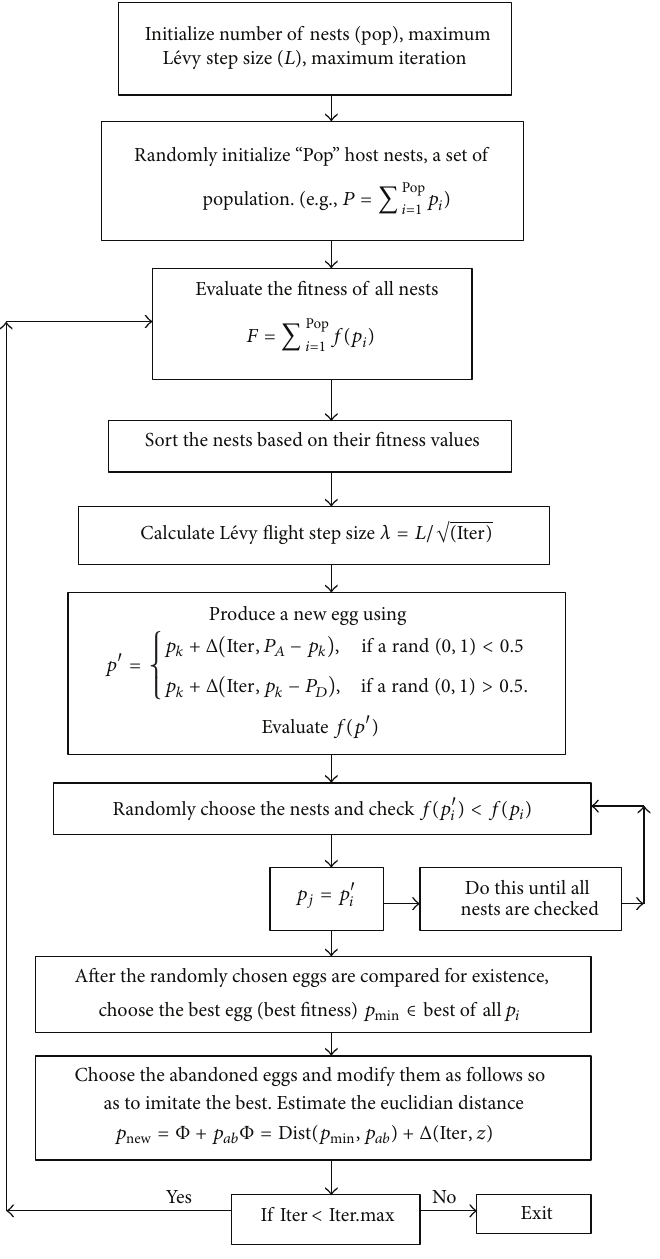
Figure 1: Flowchart of the proposed Tuned Cuckoo Search